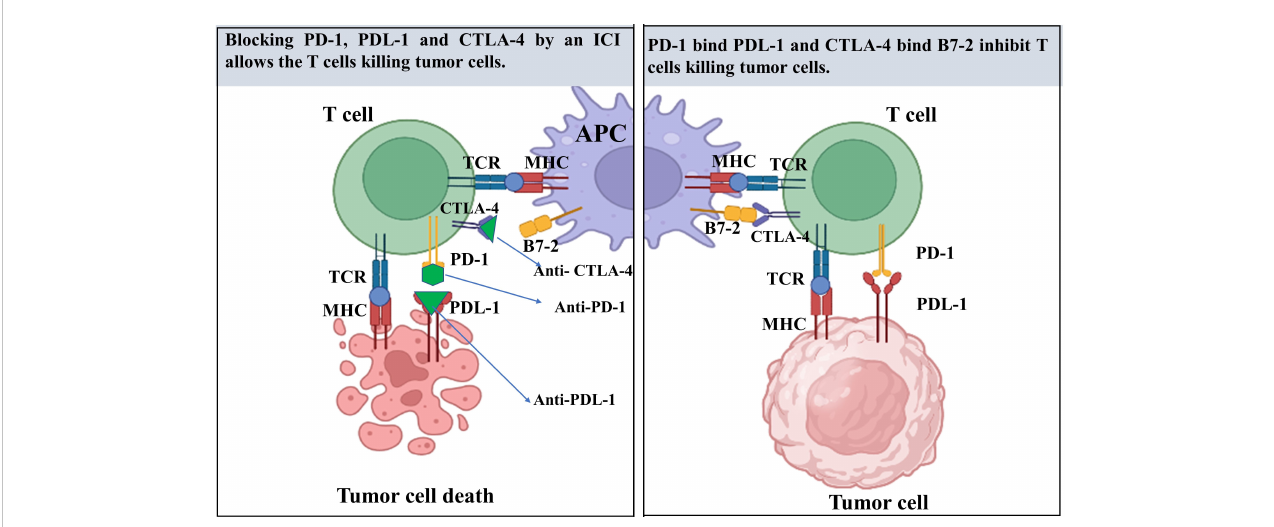
FIGURE 1 A review of the mechanism of immune checkpoint inhibitors (ICIs) in tumor therapy. T cells recognize antigen-presenting cells (APC), which are primarily dendritic cells (DCs), as well as tumor cells through T cell receptors (TCR). This molecule is responsible for recognizing fragments of antigen known as peptides that are presented to the cell surface of major histocompatibility complex (MHC) molecules. MHC present particular antigens at the cell surface for T-cell receptor (TCR) to becomes active. Co-stimulatory signals are required for T cell activation through the interaction between the CD28 receptor on T cells and the B7 ligands on APC. On T cells, the cytotoxic T-lymphocyte-associated protein 4 (CTLA-4), a co-inhibitory receptor, has been expressed and translocates to the cell membrane after T cell activation, where it competes with CD28 for ligand binding. Consequently, CTLA-4 functions largely during the fi rst phases of cancer growth. in later phase, tumor cells in the tumor microenvironments (TME) release programmed death-ligand 1 (PD-L1), which binds to programmed cell death protein 1(PD-1) receptors on T cells, resulting in a co-inhibitory signal that inhibits T cell